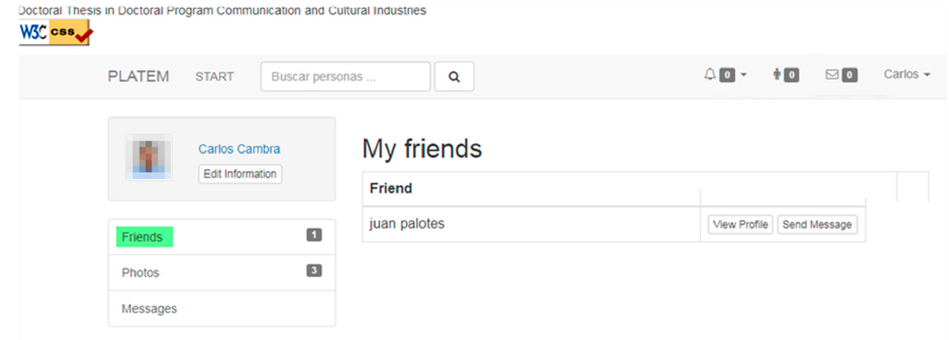
Figure 7. My Friends list.